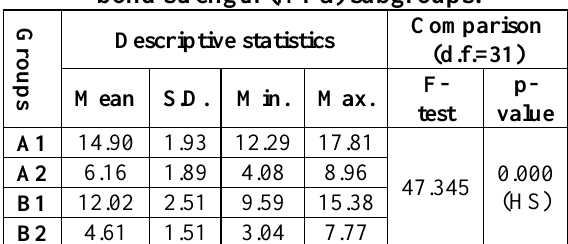
Table 1: Descriptive statistics of the shear bond strength (MPa) subgroups.